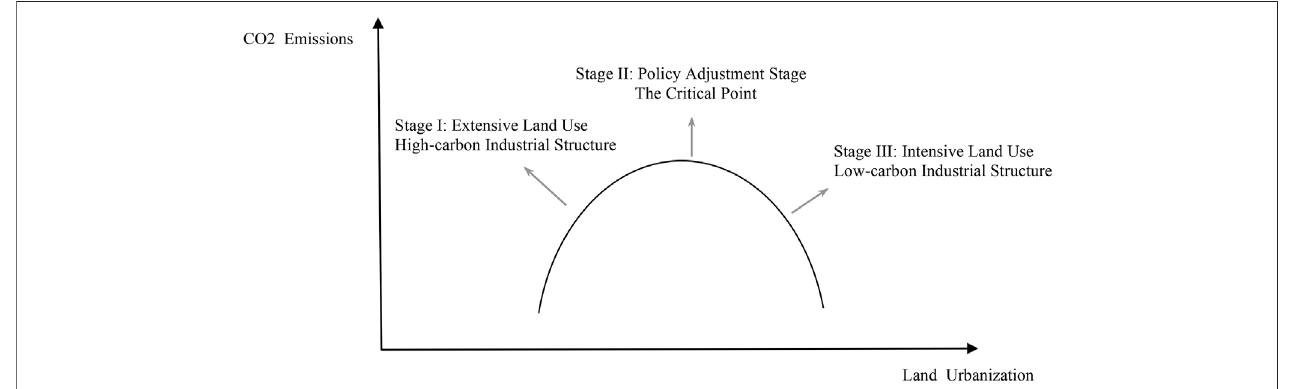
FIGURE 2 | Inverted U-shaped relationship between land urbanization and CO 2